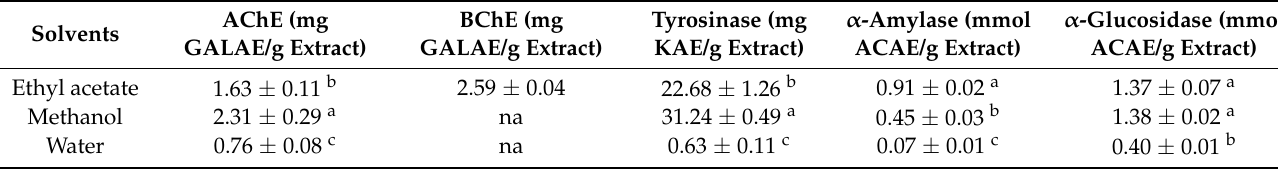
Table 4. Enzyme inhibitory of the tested